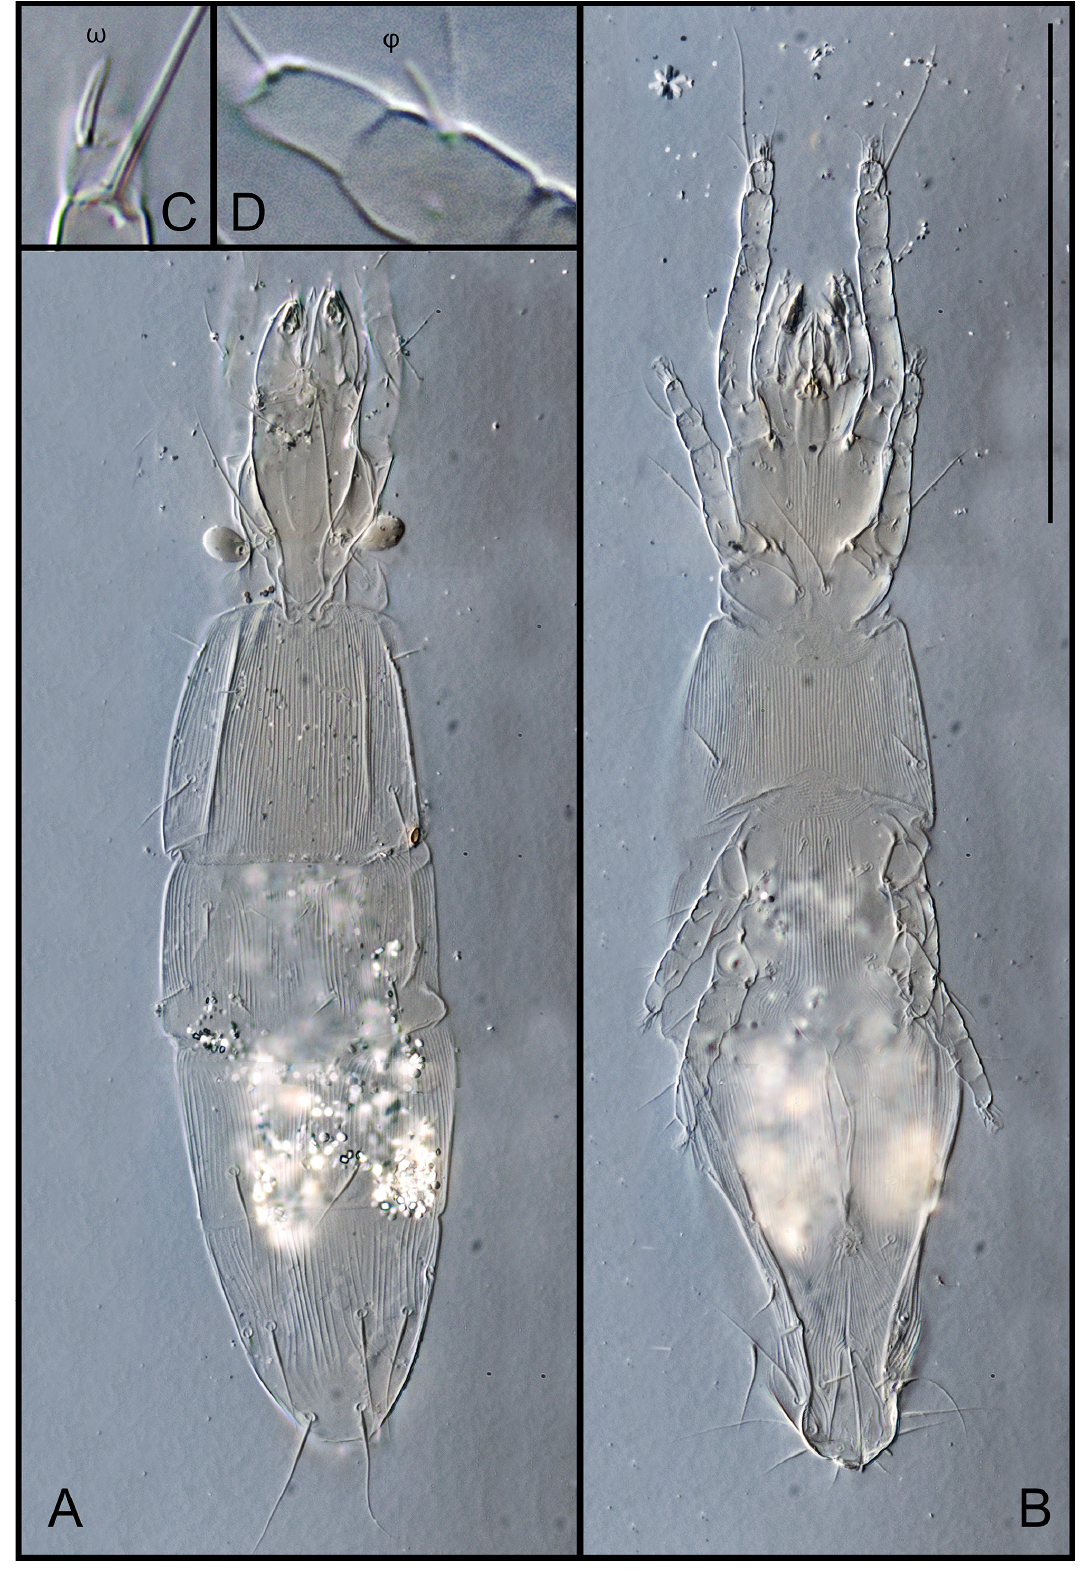
Figure 2. Paralycus daeira sp. n., female, light microscope images: ( A )—dorsal view; ( B )—ventral view; ( C )—solenidion ω I; ( D )—solenidion φ III. Scale bar 100 µm.